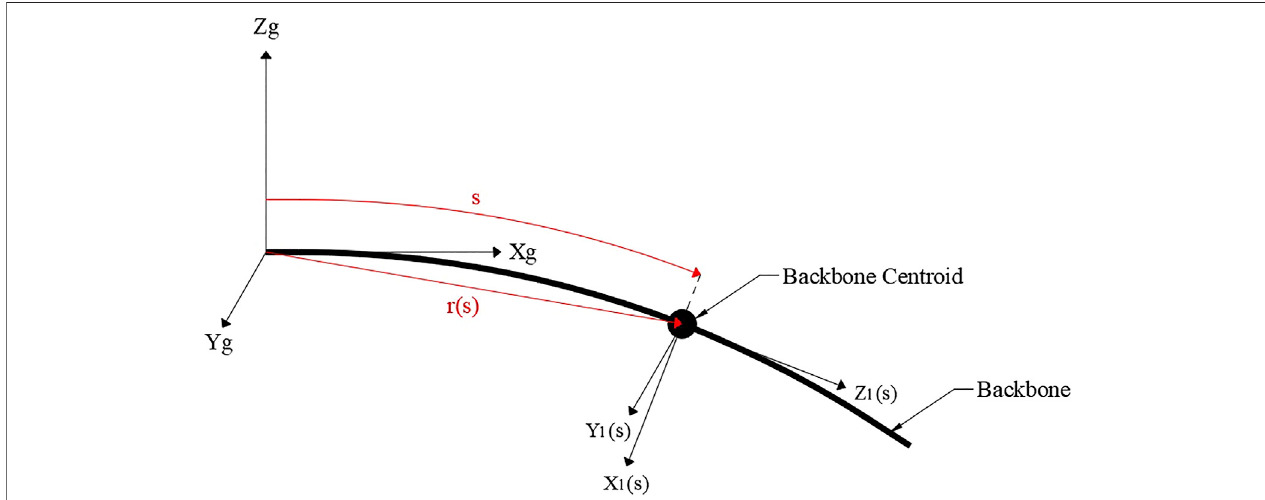
FIGURE1| Backboneshowingthebackbonecentroidatanarclength s anddistance r fromtheglobaloriginwithglobalandlocalcoordinatesystems ( Xg , Yg , Zg ) and ( X 1 , Y 1 , Z 1 ) , respectively.